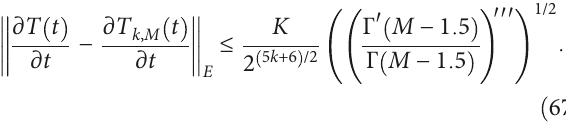
Figure 4: The geometric model of the stratospheric balloon.